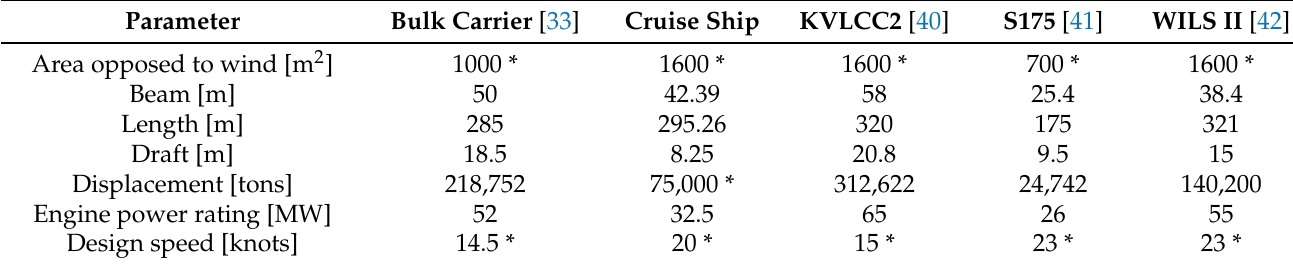
Table 3. The main particulars of tested ships. The cruise ship is based on the ship: “Mein Schiff 6”. Engine power ratings were estimated so that the engine operated at 80% load when travelling at design speed under conditions listed in Table 2. The design speeds were estimated based on